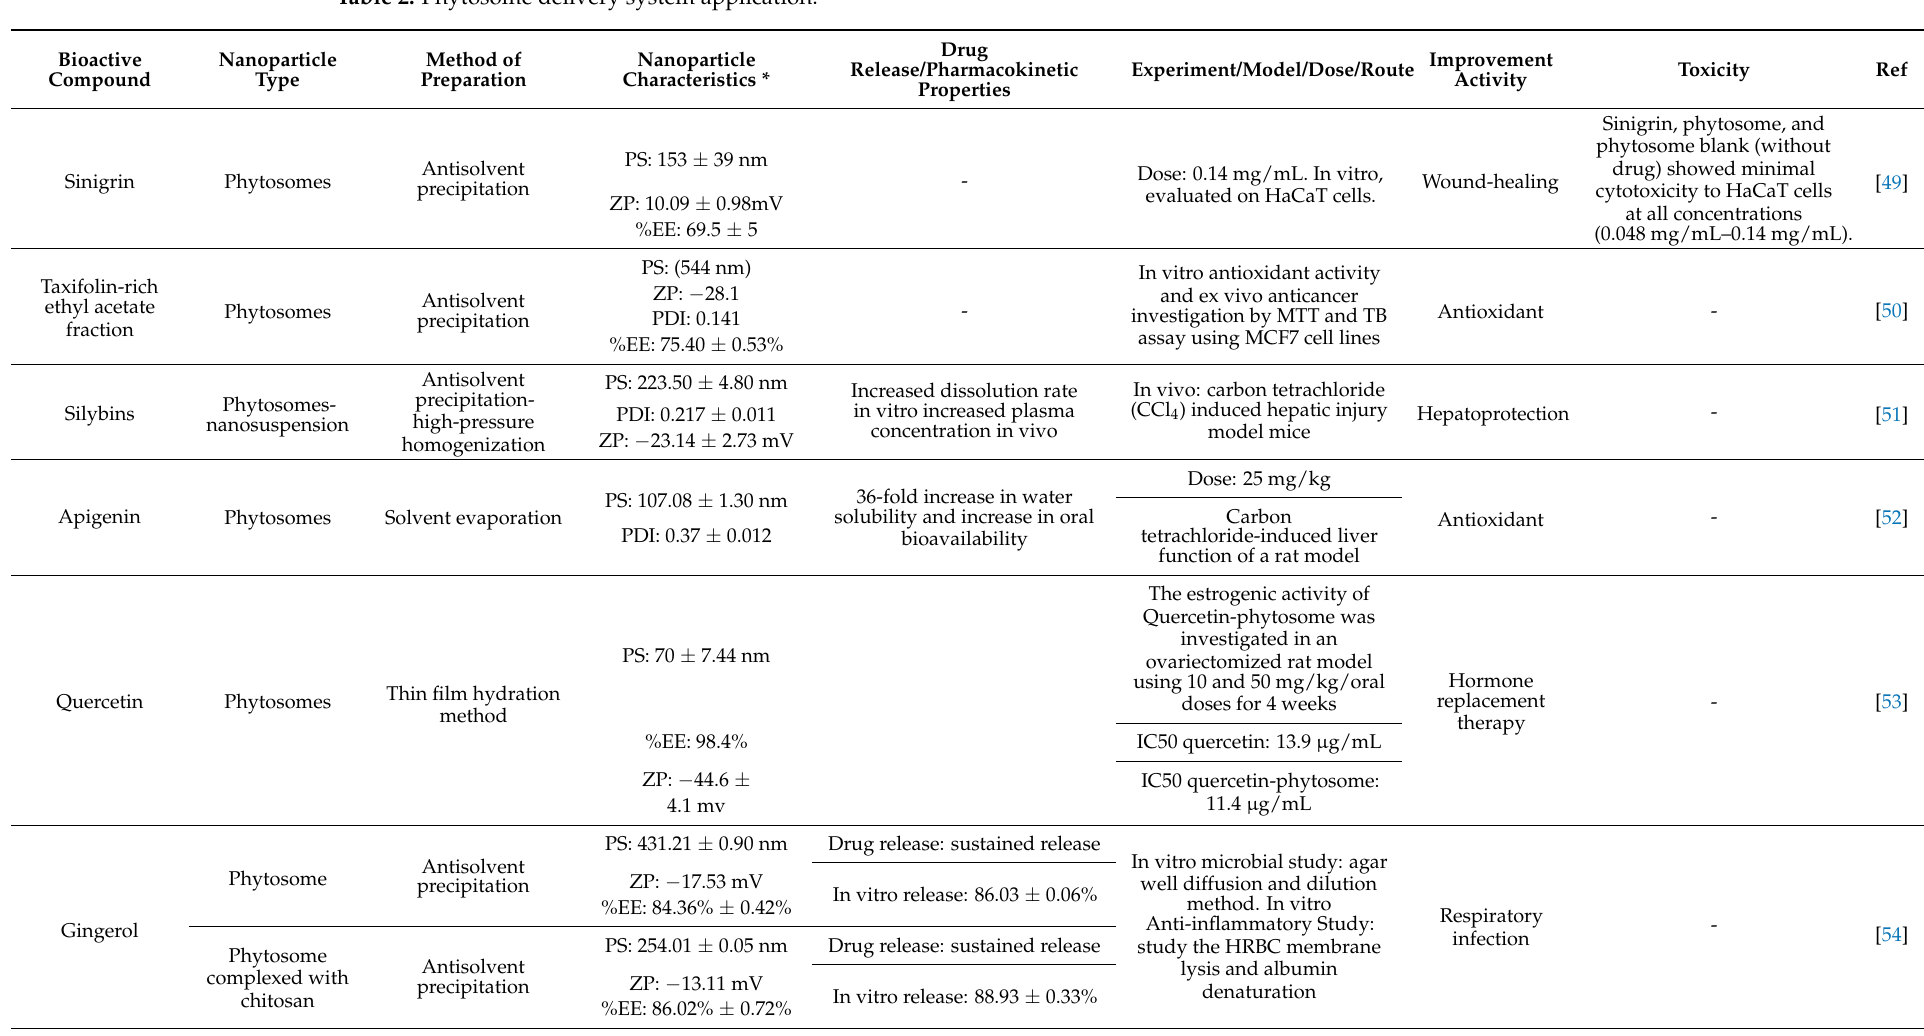
Table 2. Phytosome delivery system